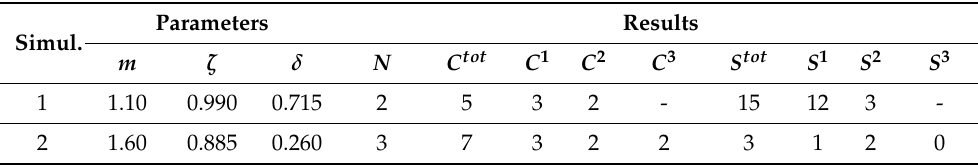
Table 3. Two different simulations (with error rate equal to 0) chosen as examples for giving the positions of prototypes and strong